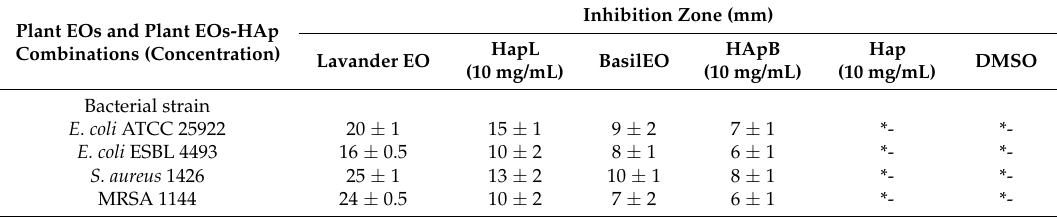
Table 4. Screening of antimicrobial activities of plant EOs, HApB and HApL respectively, via an adapted diffusion method against Gram-positive and Gram-negative bacteria. Inhibition Zone (mm) Plant EOs and Plant EOs-HAp HapL HApB Hap Combinations (Concentration) Lavander EO BasilEO (10 mg/mL) (10 mg/mL) (10 mg/mL) Bacterial strain E. coli ATCC 25922 20 ±